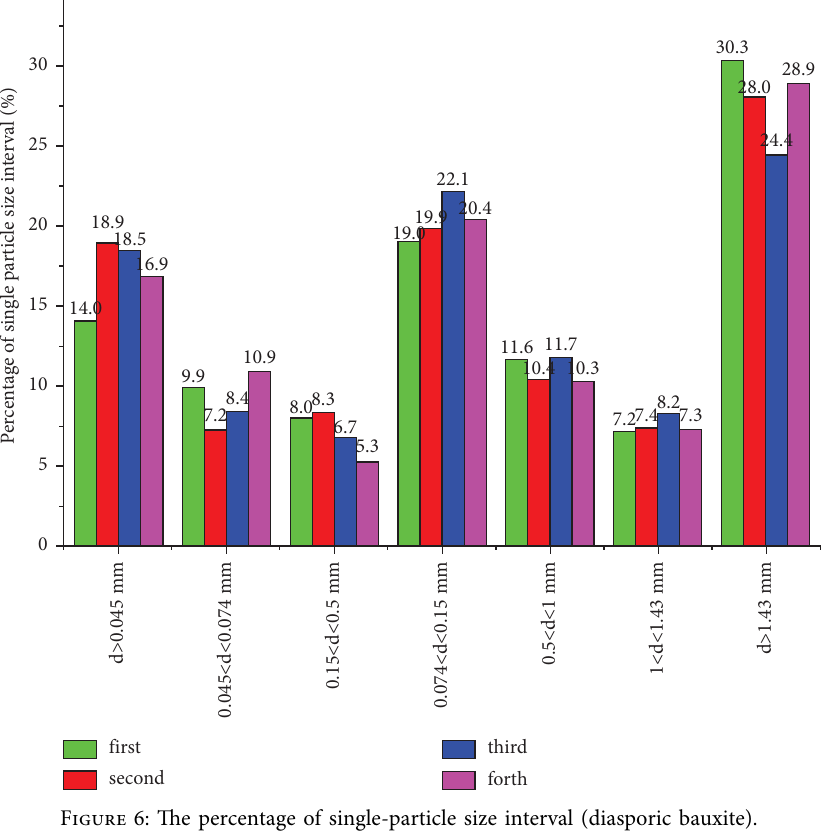
Figure 6: Te percentage of single-particle size interval (diasporic